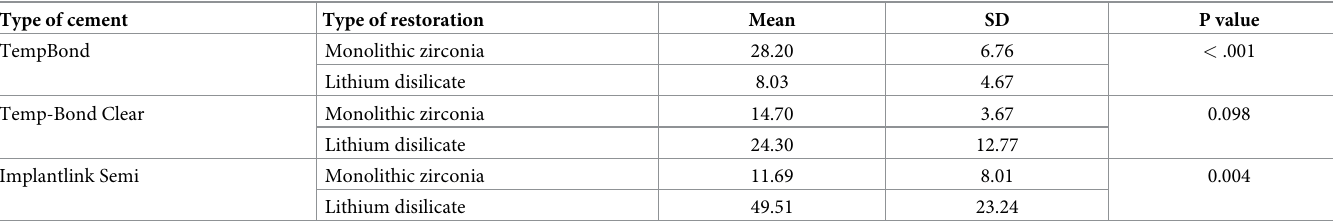
Table 6. Comparing the mean retentive strength of ceramic crowns as a function of the type of cement. Type of